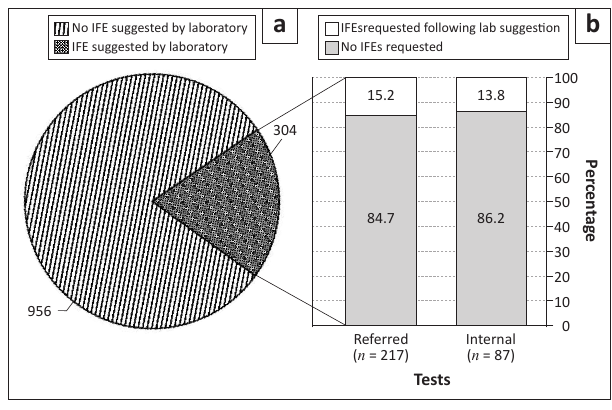
TABLE 1: Clinical histories for the 43 laboratory-suggested IFE tests requested by clinicians and performed. Clinical history (as per laboratory information system/requisition form) Query myeloma 6 Neurological complaints (for example: peripheral neuropathy; lower limb